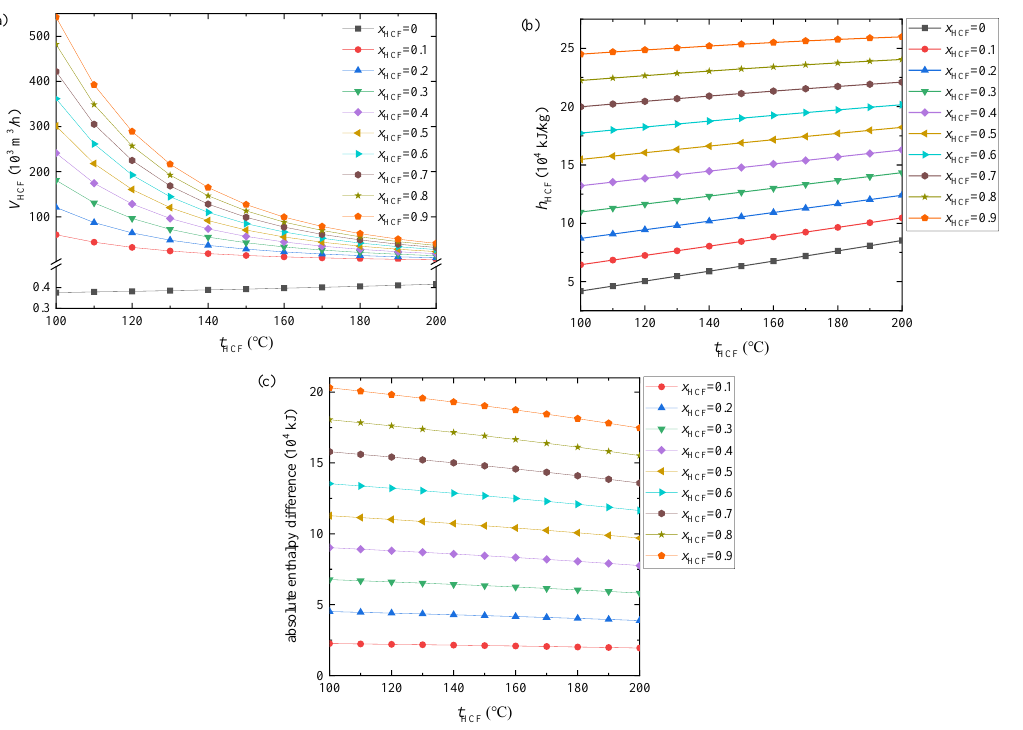
Figure 8b2. The density of CO 2 is lower than geothermal water; hence, the mass flow rate of CO 2 is smaller than geothermal water under the same temperature and pressure. As a result, the difference in enthalpy caused by non-condensable gas is not obvious enough.